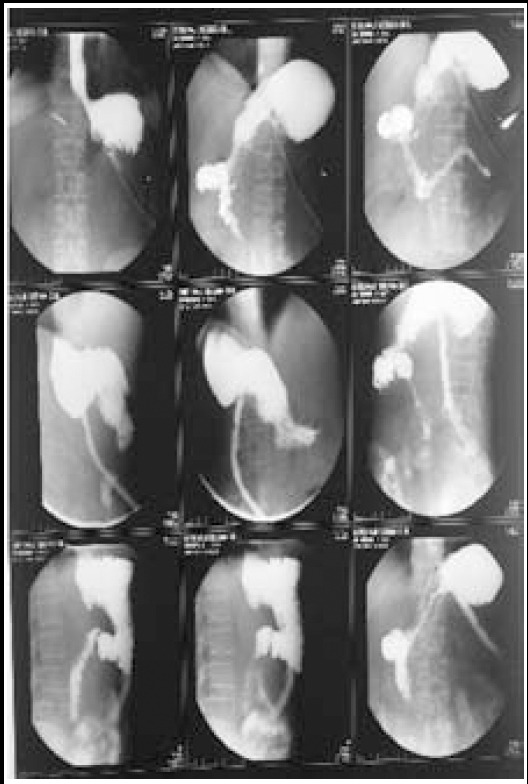
Gastrograffin film.